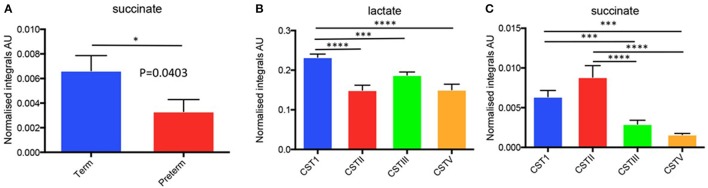
(A) Normalized metabolite data for succinate for preterm vs. term in 26–28 week cohort and (B,C) Metabolite integrals plotted in relation to CST for the total study cohort (i.e., 20–22 and 26–28 week combined). *P < 0.05, ***P < 0.001, ****P < 0.0001.